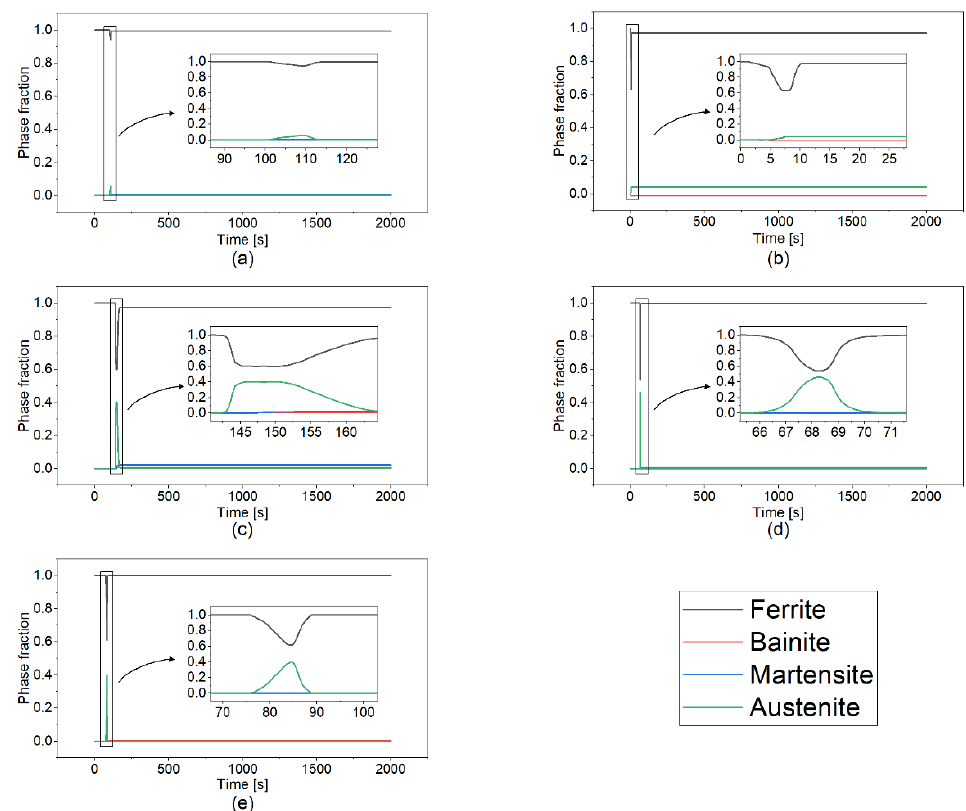
Figure 8. Phase volume fraction at the point A as a function of the scanning pattern: ( a ) alternate, ( b ) in–out, ( c ) out–in, ( d ) raster, and ( e ) zigzag. The location of the point A is explained in the Figure 7f.